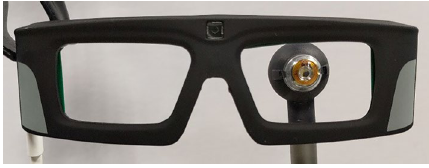
Figure 1. Eyewear and SCL mounted on a mock-up eye.